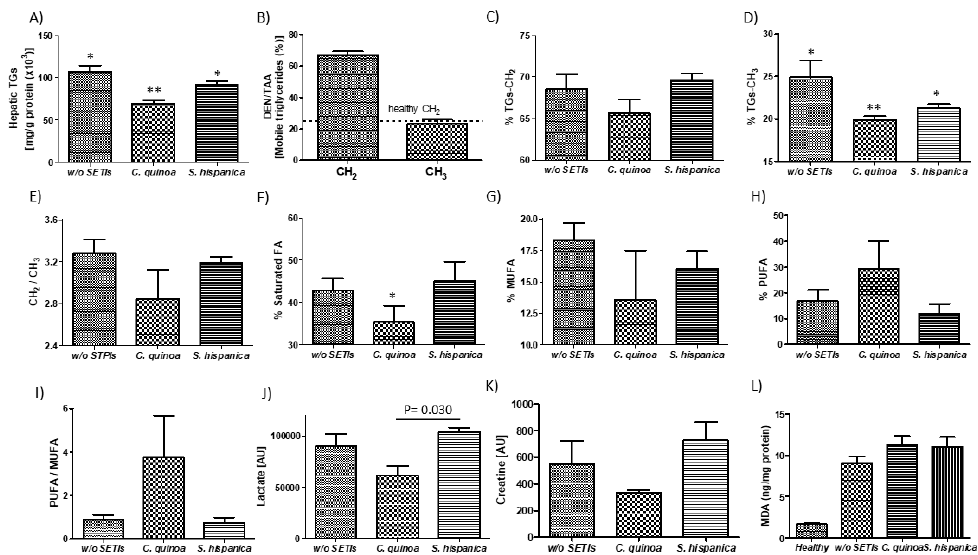
Figure 3. 1 H-MAS MR analyses of DEN / TAA-treated mice fed high fat diet administered with or without protease (serine-type) inhibitors (PIs) (100 µ g / animal). ( A ) Colorimetric determination of total hepatic triglyceride content. 1 H-MAS MR levels of triglyceride-CH 2 ( B ) and triglyceride-CH 3 ( C ) in tissue from HCC developing mice. ( D – F ) Lipid patterns for saturated fatty acids, MUFA and PUFA. ( G – I ) 1 H-MAS MR levels of lactate ( J ), creatinine ( K ). Quantification of the oxidation marker malonaldehyde (MDA) in liver samples of HCC developing mice ( L ). Results are expressed as mean